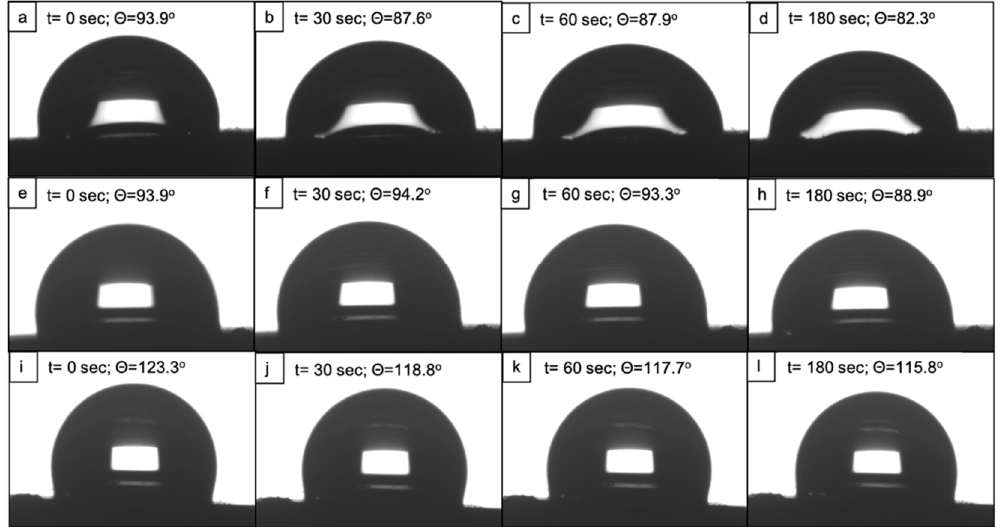
Figure 5. Evolution of a water droplet on the surface of fs-laser processed and control scaffolds for a period of 3 min. First-row images ( a – d ) represent a water droplet on scaffolds irradiated with F = 0.08 J/cm 2 ; N = 10; second-row images ( e – h ) represent a water droplet on scaffolds treated with F = 0.08 J/cm 2 ; N = 2; third-row images ( i – l ) depict the hydrophobic nature of the control PCL scaffold.